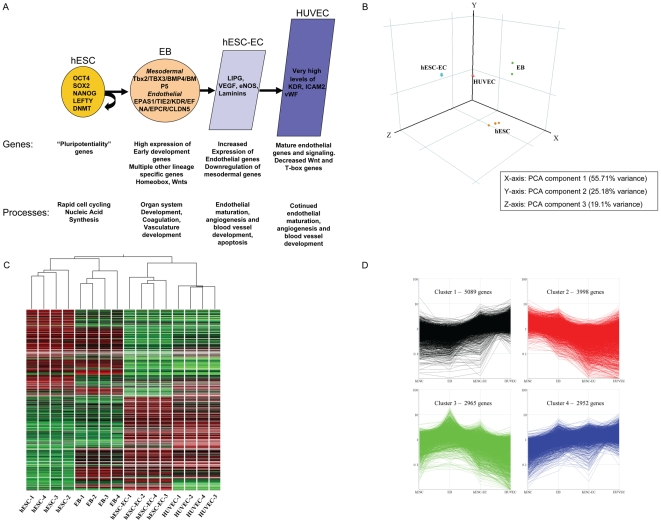
Major themes in gene expression profiles at each stage of differentiation.(A) hESCs express high levels of pluripotency-associated genes including Oct4, Sox2, NANOG, Lefty, and DNMT. At the EB stage, the cells express high levels of mesodermal master regulators such as Tbx2, and BMP4 as well as very enriched levels of endothelial specific master regulators including EPAS1, TIE2, KDR, and EFNA. This population also expresses genes from other cell layers, and many developmental genes from Wnt and homeobox families. hESC-ECs downregulate early mesodermal genes and express more endothelial specific genes, while HUVECs have the highest levels of mature endothelial gene expression with very few other developmental lineages represented. (B) Principal Components Analysis (PCA) shows that replicate experiments of each cell type are very similar while differentiation groups separate significantly along components 1 and 2. (C) Hierarchical Clustering Analysis - Cells from each developmental stage cluster relatively close to each other, with the most distance between hESCs and HUVECs. (D) K-means clustering analysis identifies major trends in gene expression across the time course.